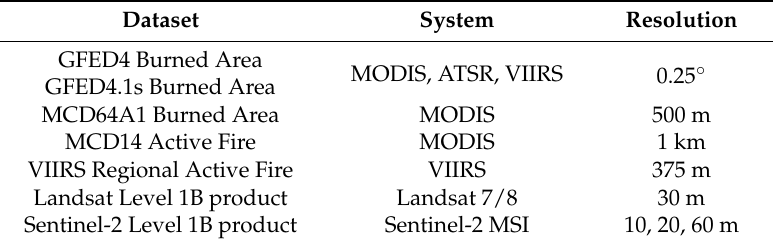
Table 1. Summary of the multi-sensor datasets used